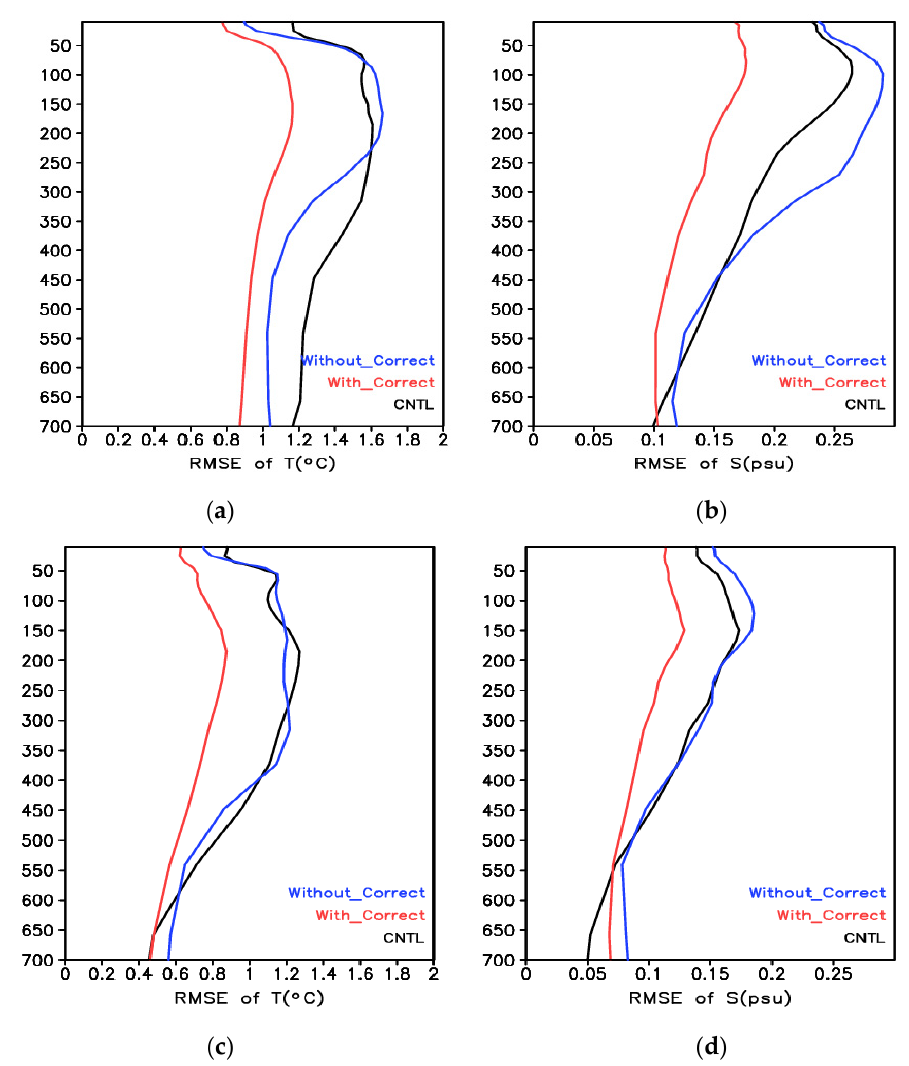
Figure 5. Vertical distribution of the RMSEs of ( a , c ) temperature and ( b , d ) salinity for different ocean basins and different experiments over the period 1993–2005. ( a , b ) Southern Indian Ocean; ( c , d ) Southern Pacific Ocean.